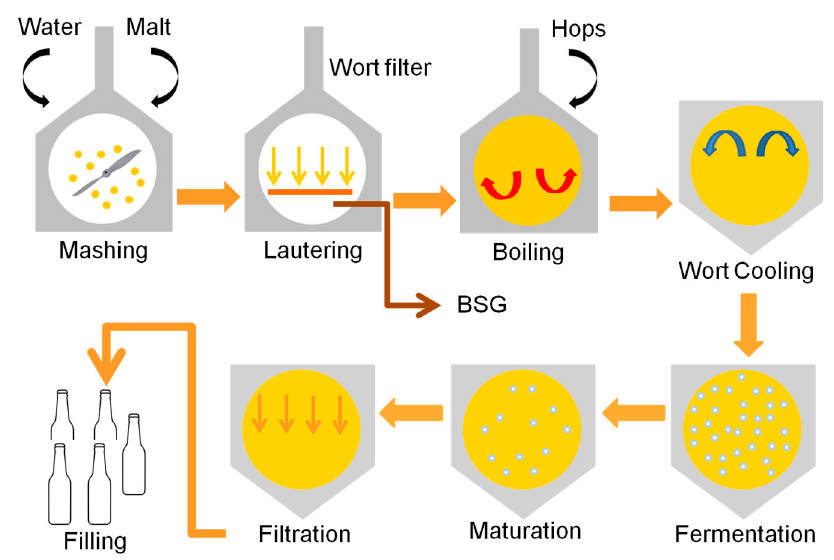
Figure 1. Simplified scheme for brewing. BSG, brewers’ spent grain.